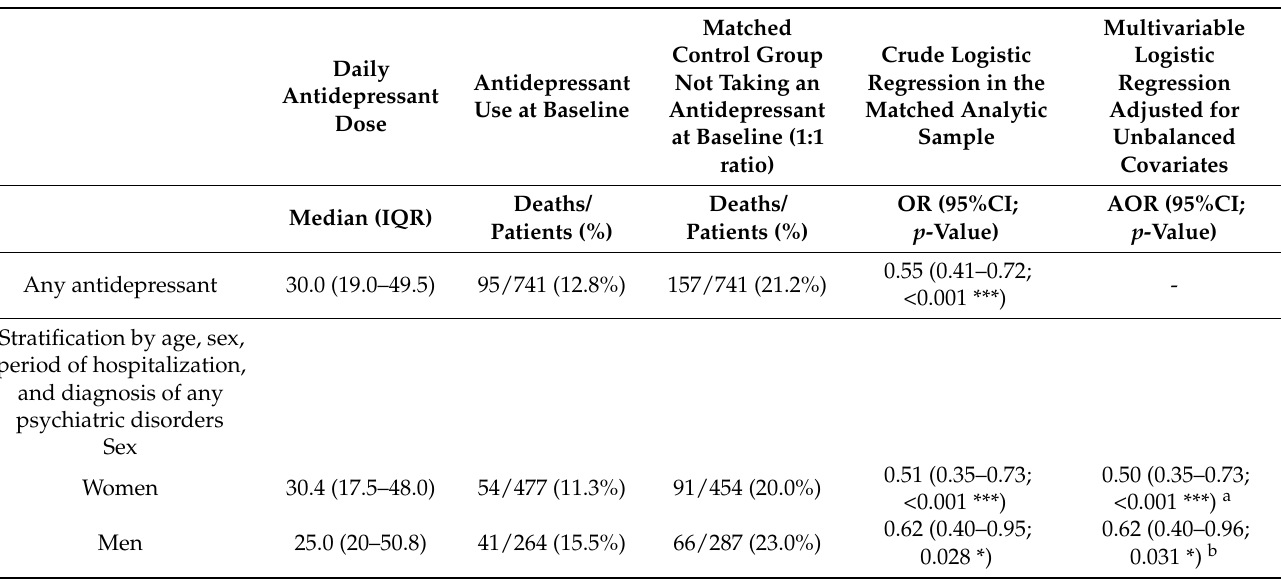
Table 2. Antidepressant use and 28-day all-cause mortality in a matched analytic sample of patients hospitalized with COVID-19 (N =